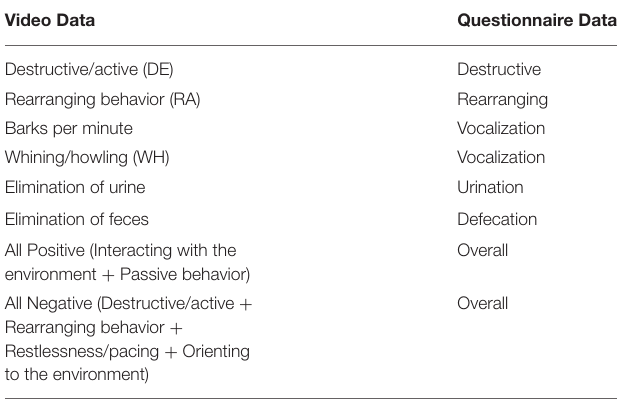
TABLE 6 | Variables used to compare the video data and questionnaire